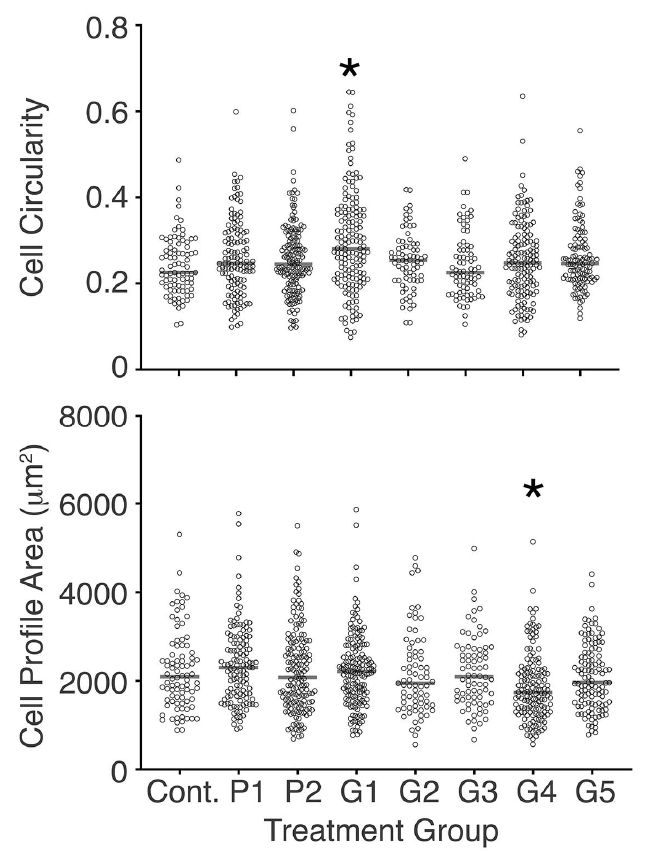
Figure 3. Scattergrams showing cell circularity and cell profile area on day 3.5 of culture, for all cells tracked at that time point. Median values are shown by horizontal bars. Only modest effects of conditioned media were seen, with the exception of medium conditioned by G1 and G4 where there was a significant difference compared with control cells (* p < 0.05, Mann–Whitney U test).